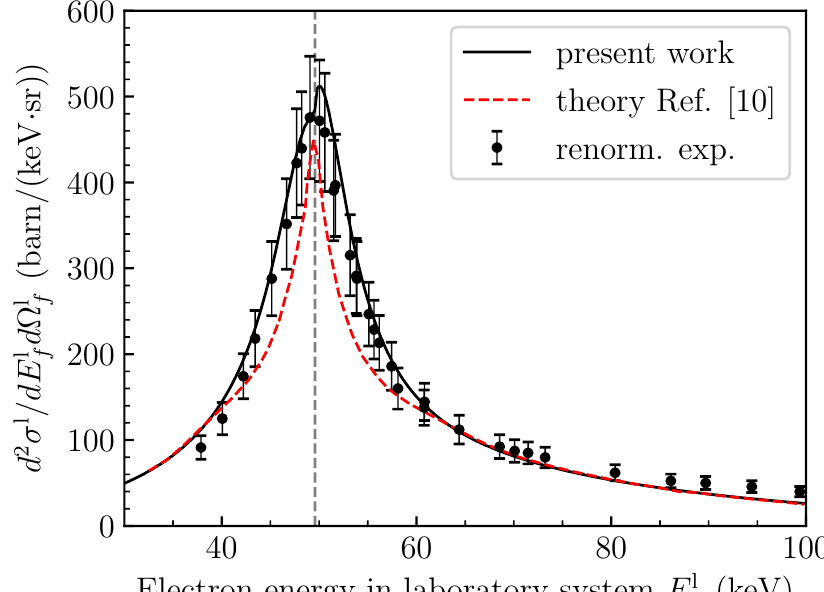
Figure 1. DDCS for ELC observed at θ l 0 ◦ in the 90.38 MeV/u U 88 + -N 2 collision. The theoretical f ≈ predictions and experimental data of Ref. [10] (renormalized to our results) are also shown. The vertical = 49.58 keV corresponds to the line at E l f